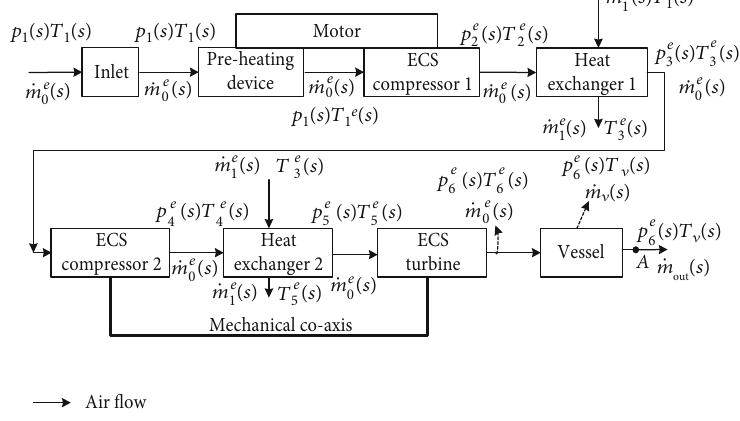
Figure 4: The operation fl owchart of an aircraft electrical